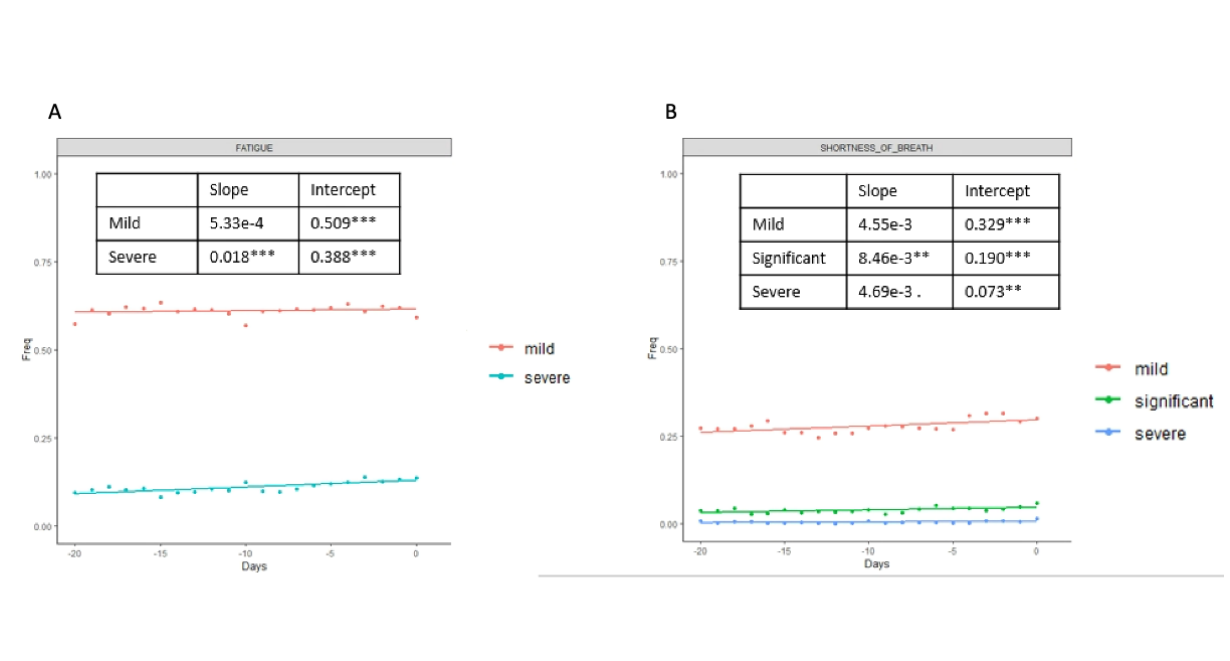
Figure 4. Categorical features of fatigue and shortness of breath are plotted for the negative group in longitudinal